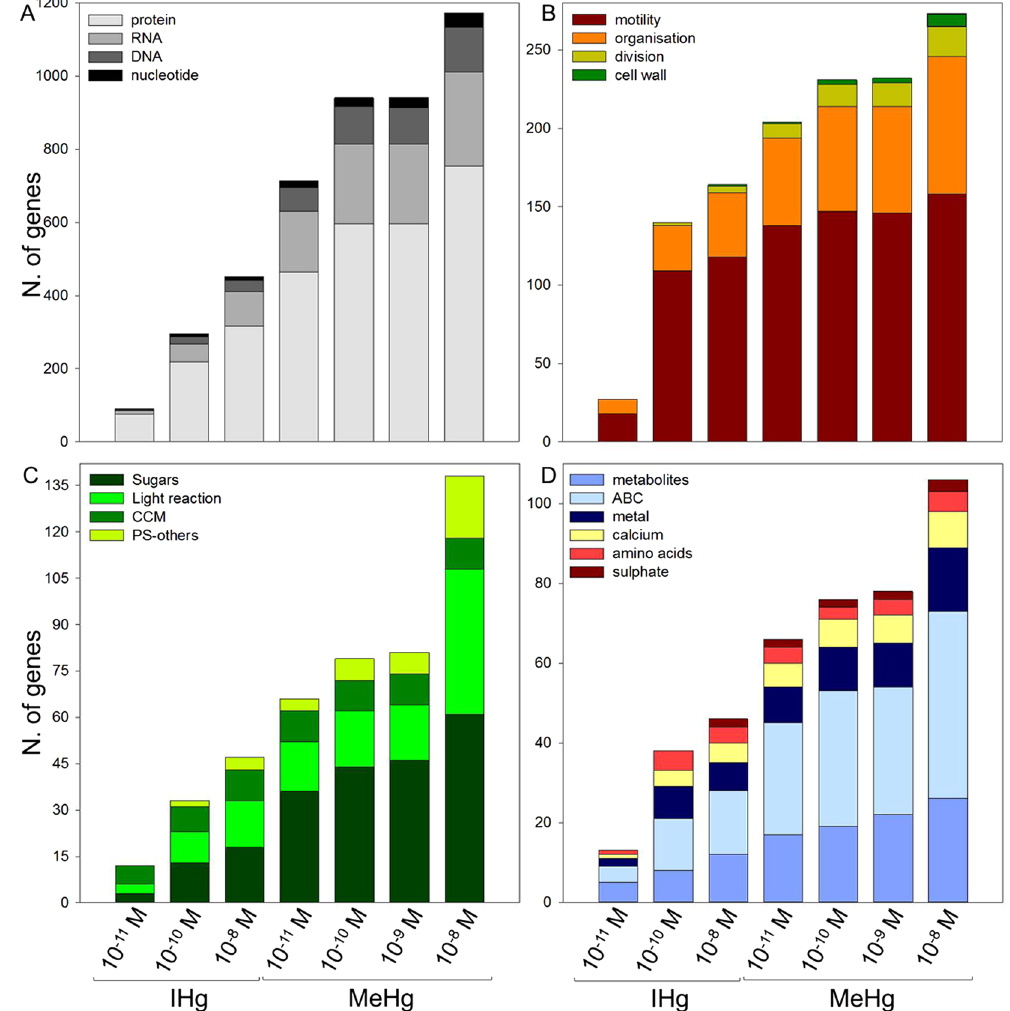
Figure 2. Number of genes significantly dysregulated in C. reinhardtii after 2 h exposure to increasing concentrations of IHg or MeHg (MapMan) in the categories involved in gene expression ( A ), cell processes ( B ), energy metabolism ( C ) and transport ( D